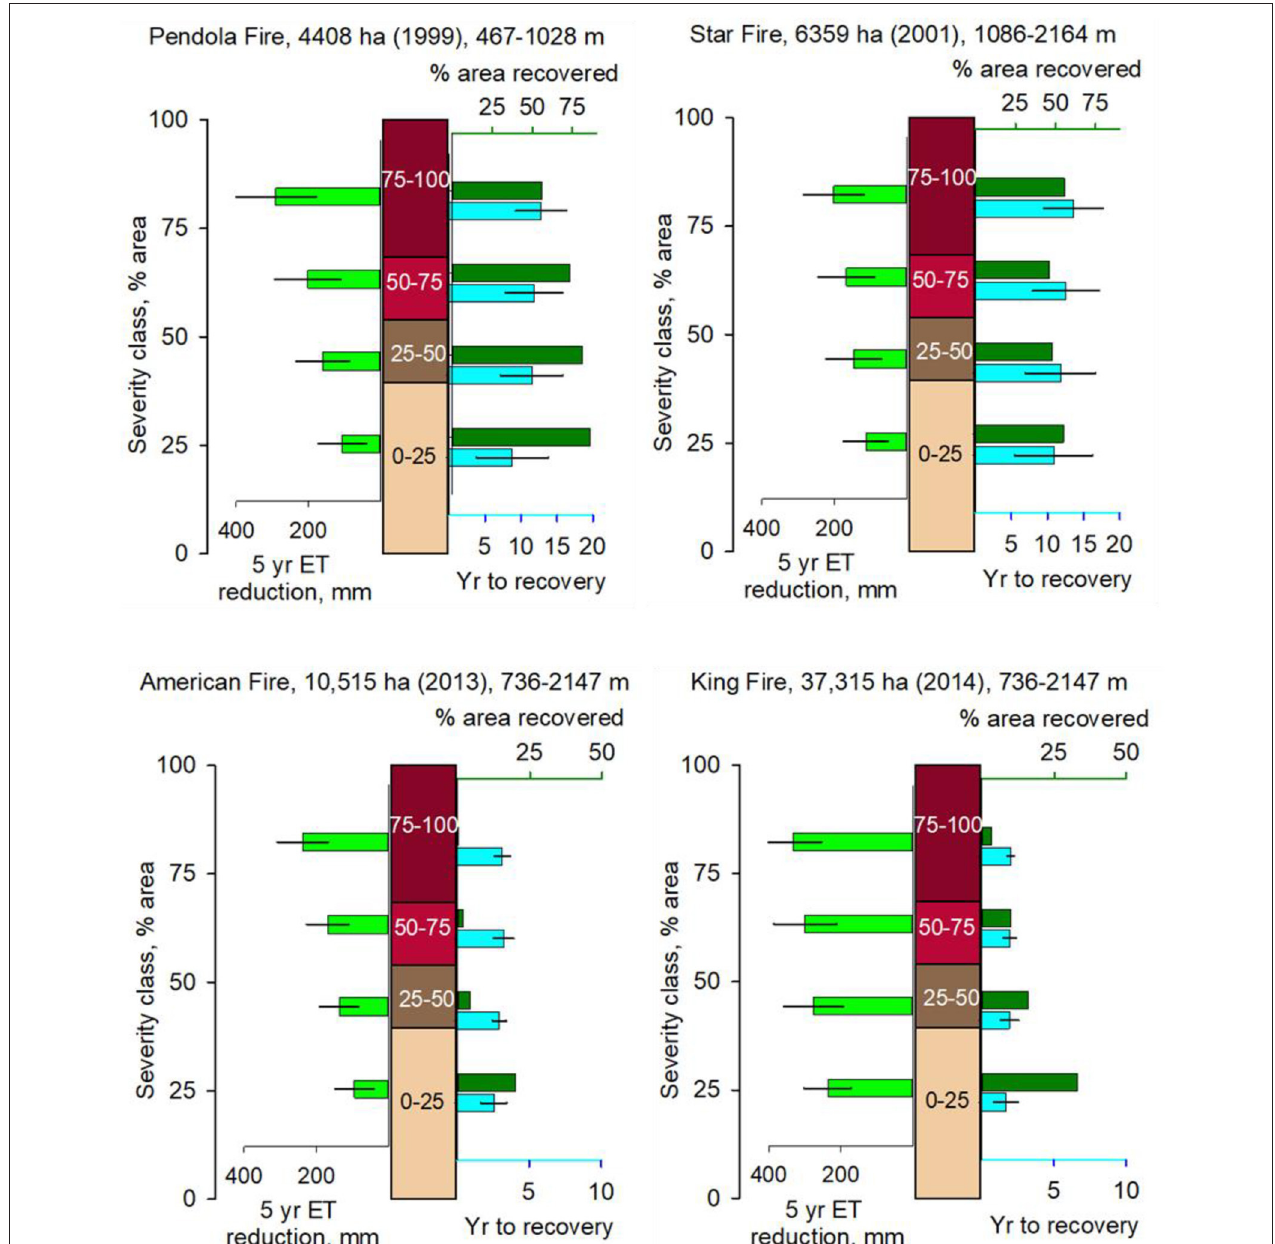
FIGURE 5 | Evapotranspiration (ET) reduction and recovery to pre-fire levels for four large fires that burned with a range of severity classes. Center, vertical bar shows percent area of fire in each of the four severity classes. Bars on the left show ET reduction by fire (mean and standard deviation), averaged over 5 years post-fire, by severity class (highest bar is highest severity class). The four pairs of bars on right also correspond to the four severity classes, with the upper bar being area recovered and lower bar in each pair being years to recovery of pre-fire ET levels (mean and standard deviation); the number of years to recovery refers only to those grid cells where net ET change is greater than or equal to zero relative to pre-fire and unburned grid cell ET values (see Equation 5). The remaining grid cells had not recovered as of 2018. The proportion of mixed conifer for each fire is 73% (Pendola), 80% (Star), 83% (King), and 95% (American).